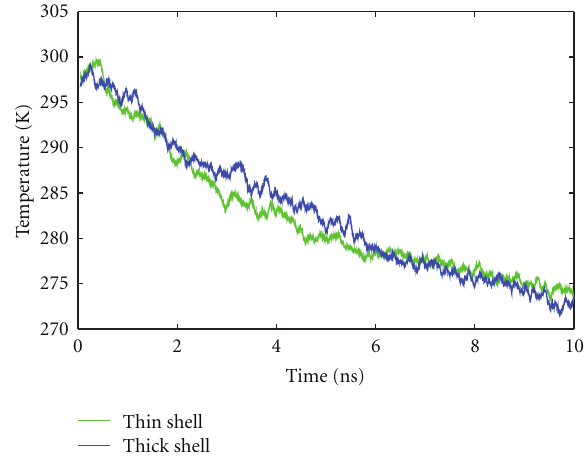
Figure 3: Temperature of ubiquitin during the evaporation process. Data are averaged over 3 simulation runs; the statistical error is ± 2K, Table 1. Table 1: Absolute number N evap and fraction N evap /N of water molecules that have evaporated after simulations of 10ns. Average temperature T of the final protein-water cluster, averaged over the last 0.5 ns of the simulations.